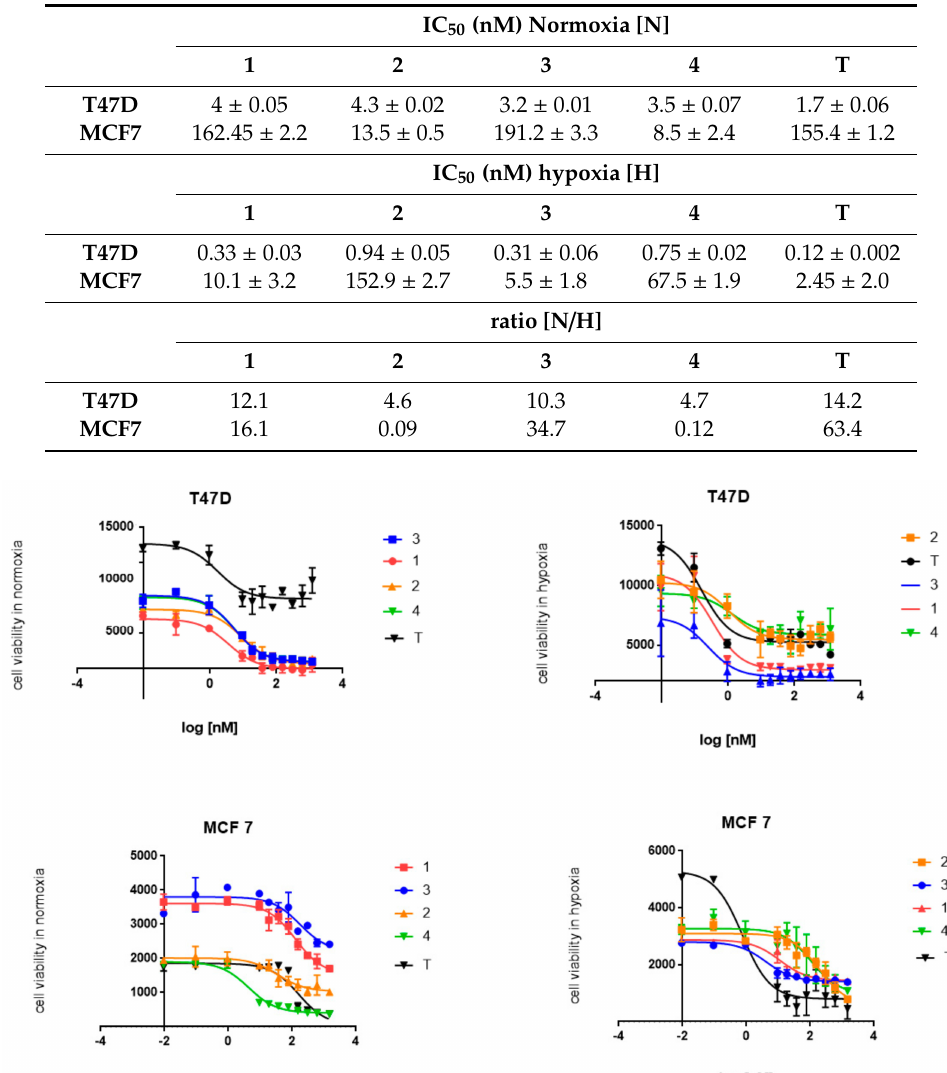
Table 1. Tested benzimidazole derivatives (1–4) and reference compound tirapazamine (T) and their cytotoxic e ff ects on T47D and MCF7 cells in normoxic and hypoxic conditions. The data are presented as IC 50 for n = 3, mean ± SD.